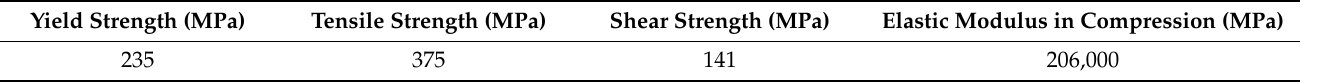
Table 3. Mechanical properties of carbon steel taken from Ref. [12].